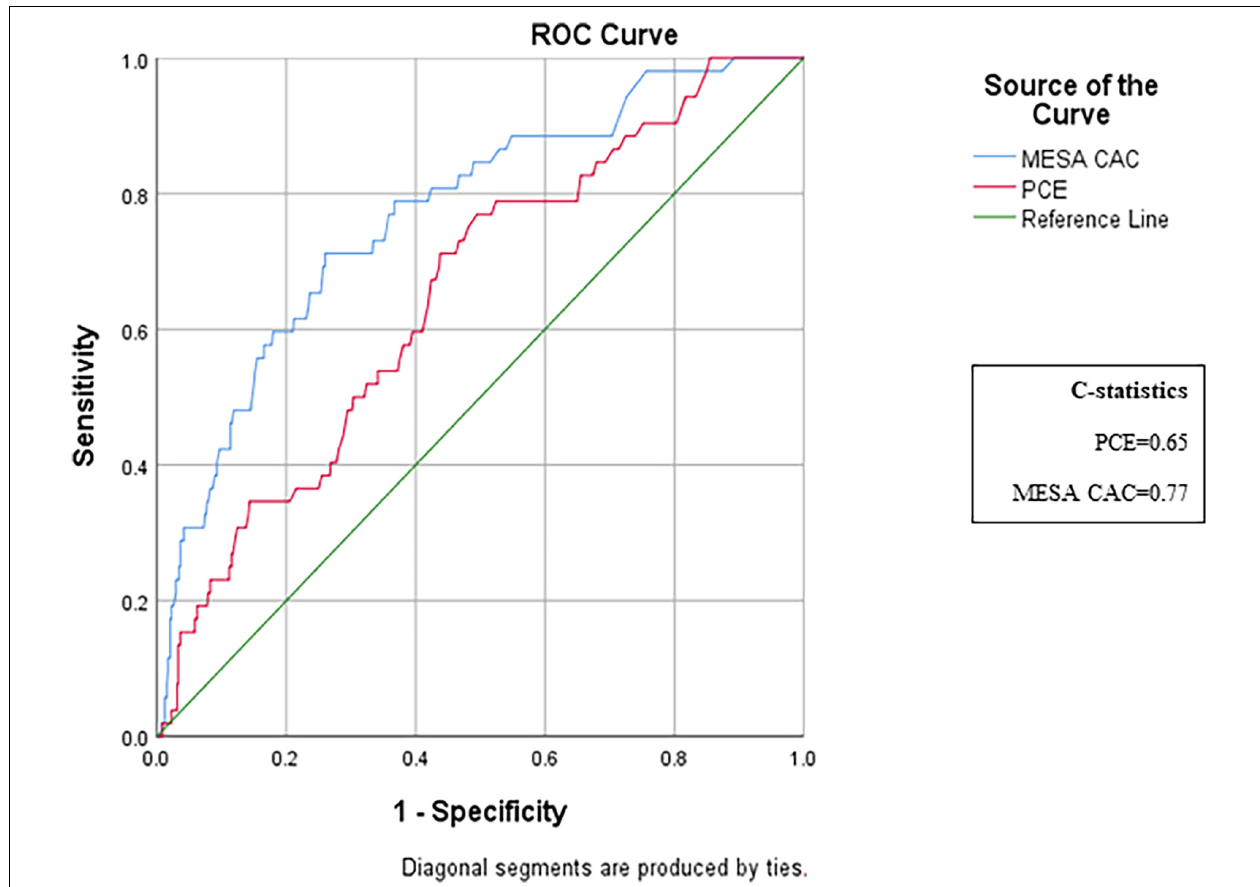
FIGURE 2 | ROC analysis of the discriminative ability for the prediction of cardiovascular events by PCE and MESA risk scores. ROC curves comparing the predictive ability of MESA-C and PCE scores. The MESA-CAC curve is designated in blue, the PCE curve is in red, and the reference line is in green. ROC, receiver operating characteristic; PCE, pooled cohort equations; MESA, multiethnic study of